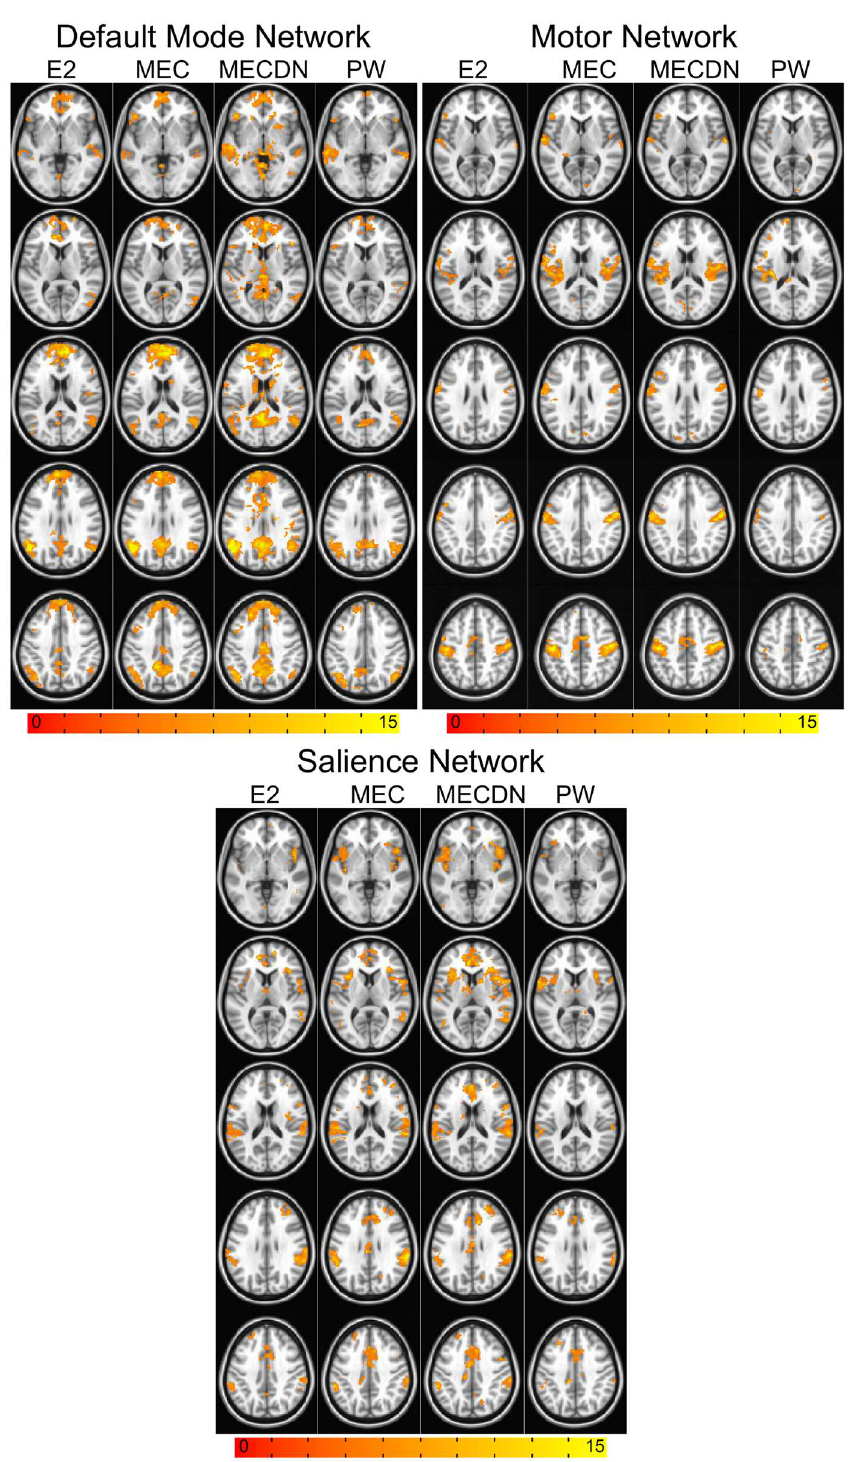
Fig 7. Group dual-regression based functional connectivity maps. Connectivitymaps are displayedfor the default mode network, motor network, and saliencenetwork. Maps are the result of a one-sample t-test on the z-scores and were thresholded at P < 0.005 with minimumcluster size = 46, α = 0.05. Additionalclusters were seen for the MEC data compared to the E2 data and for all networks, and for the MECDN data compared to the MEC data for the DMN and saliencenetworks. Existing clusters also tended to be larger for the